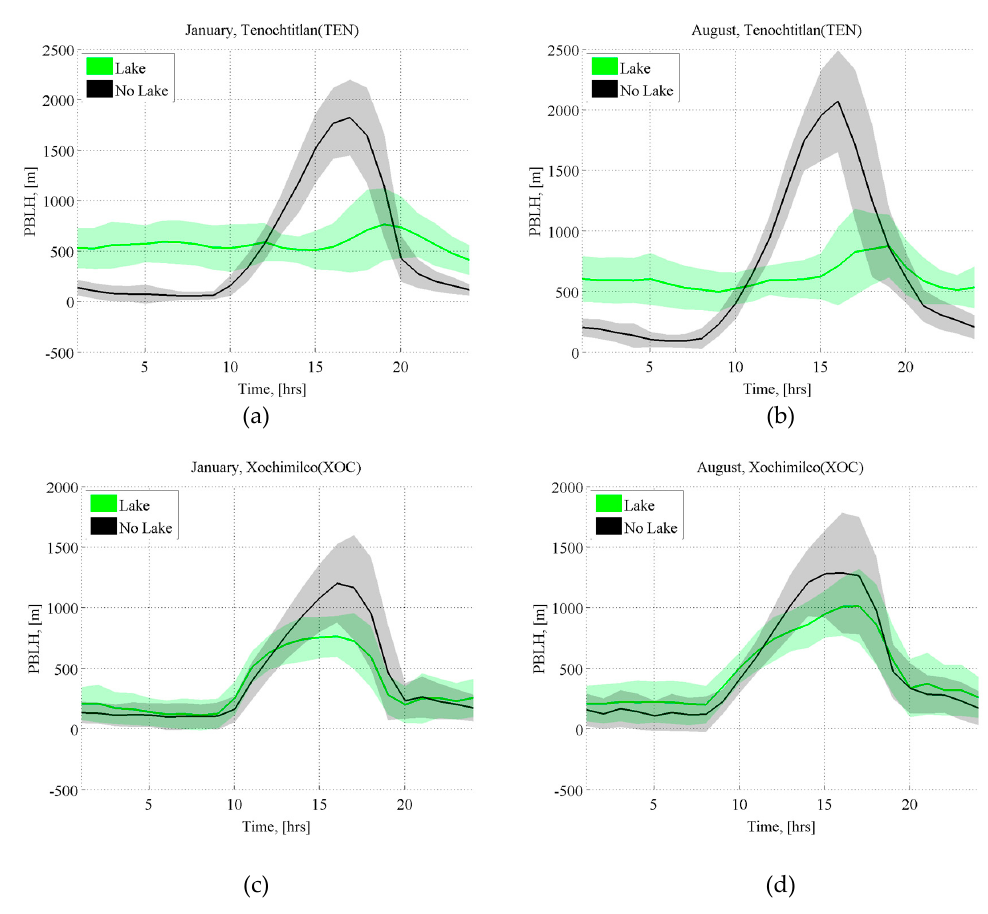
Figure 9. Hourly means of the planetary boundary layer height (PBLH) at Tenochtitlan in January ( a ) and August ( b ), and at Xochimilco in January ( c ) and August ( d ). Green colors correspond to the L/WRFc simulation and black-gray colors correspond to the NL/WRFc simulation. The solid lines correspond to the mean monthly values of the hourly PBLH data and the bands represent the associated variability for the particular month and station. (No-Lake: NL/WRFc; Lake: L/WRFc.)